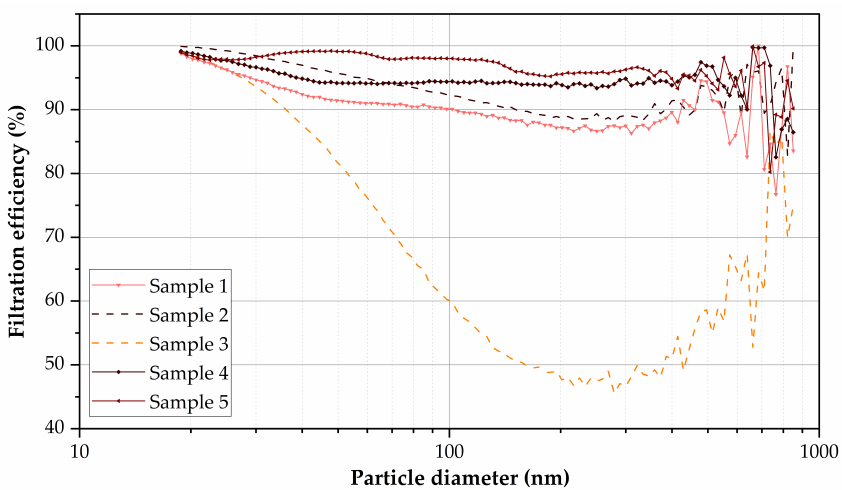
Figure 5. Filtration efficiency using different parameters during electrospinning with a 25 wt.% PET solution. The noise to signal ratio of the curves increases from 0.6 µm because the equipment used is not designed to analyze coarse particles. Particle concentration >0.6 µm ( ∼ 1 × 10 5 particles/cm 3 ) is reduced compared to that of particles between 0.1 and 0.6 µm ( ∼ 2.5 × 10 5 –7 × 10 5 particles/cm 3